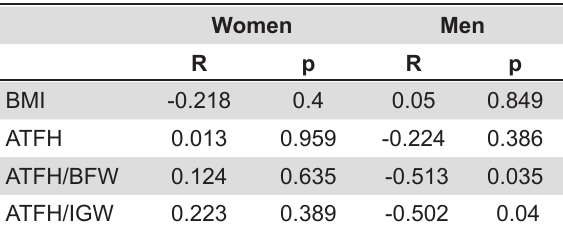
*R= Pearson’s correlation coefficient; p= Probability